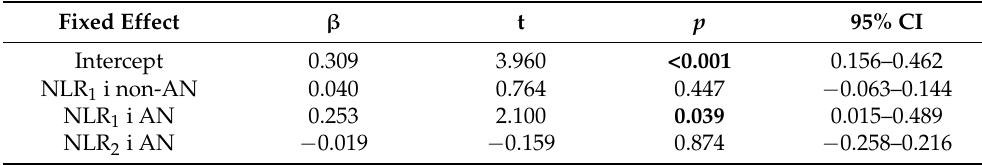
Table 3. Summary of the fixed effects of the final model for log(NLR x ). NLR 1 —neutrophil to lym- phocyte ratio value from the first peripheral blood count, non-AN—non-antipsychotics-naïve, AN—antipsychotics-naïve. 95% CI—95% confidence interval. Statistically significant p -values are bolded .